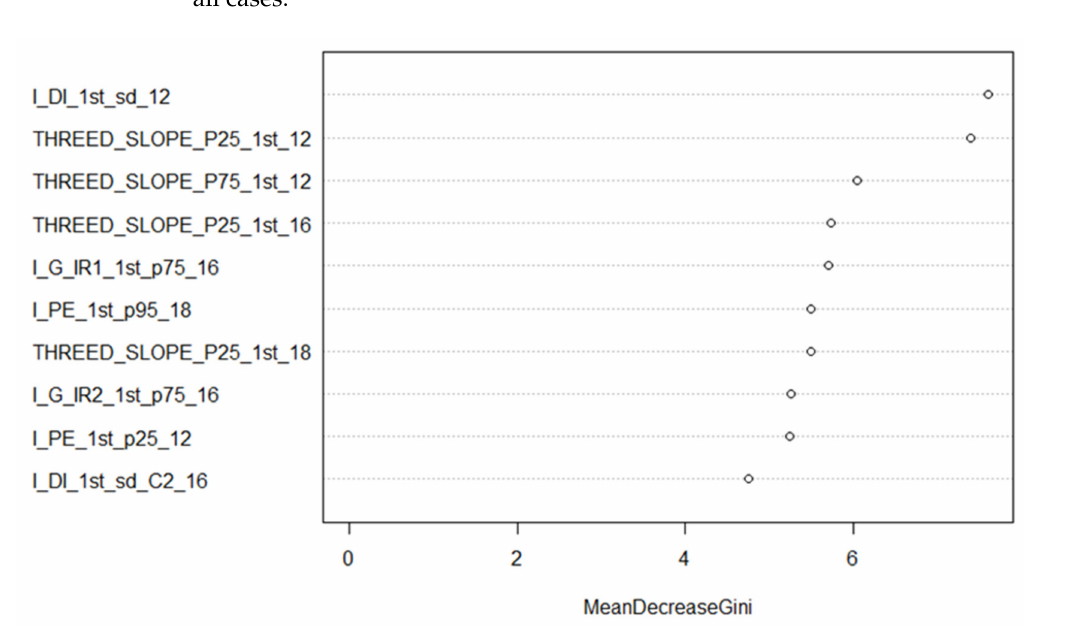
Figure 4. Mean Decrease Gini for the 12 species classification (all sensors, top 10 features). The suffix after each feature (_12, _16, _18) refers to the dataset (ALS12, MSL16, SPL18) from which the feature was calculated.